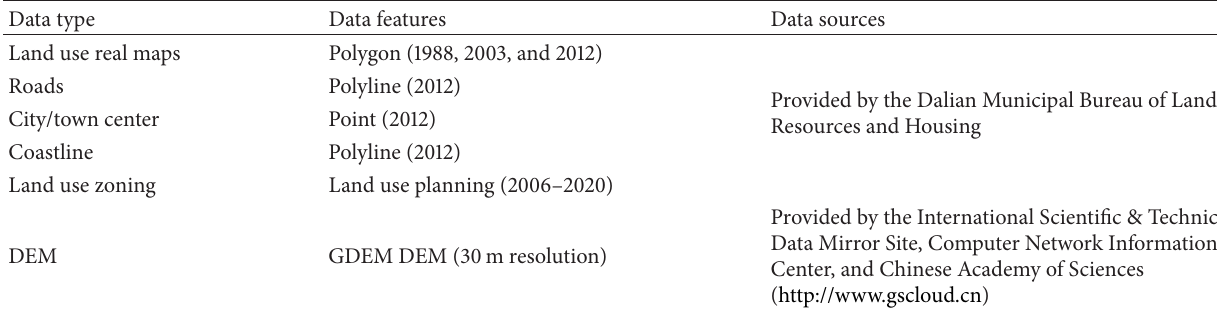
Figure 5: Location of the Jinzhou New District. Table 1: Data sources and